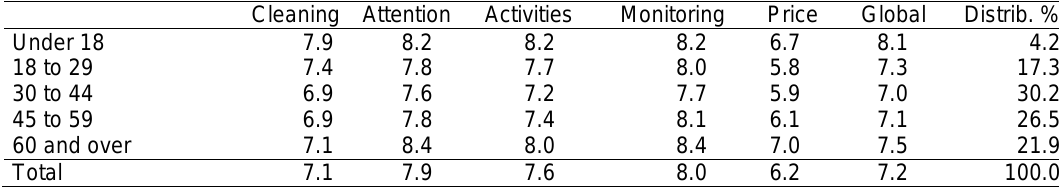
Table 8. Assessment of sports facilities by age group (2017). General report.